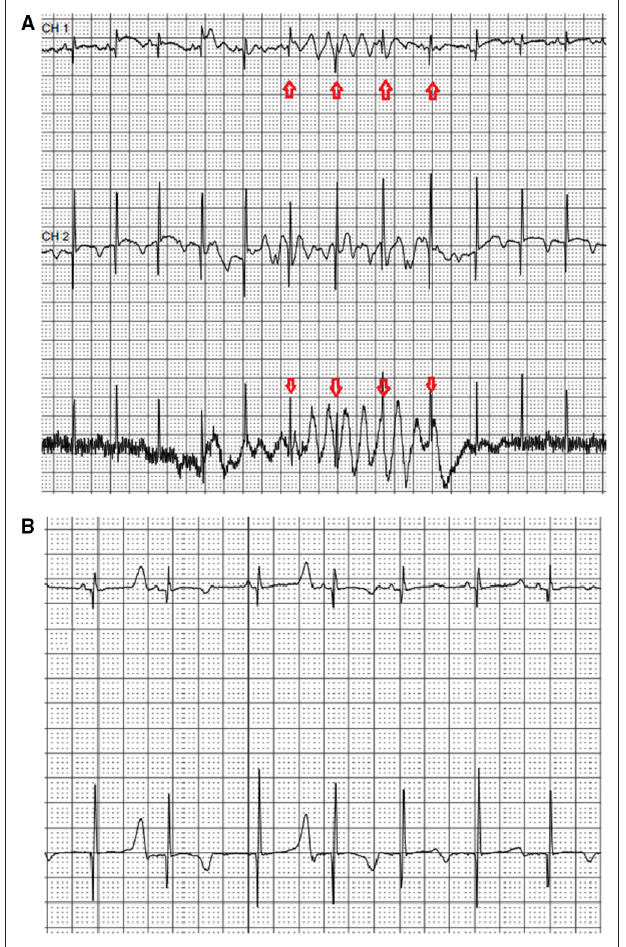
FIGURE 2 | Neonatal 24-h ECG recording. Recording artifacts simulating ventricular arrhythmia -arrows (A) and presence of T wave alternans (B) during the first day of life in 24-h ECG recording.